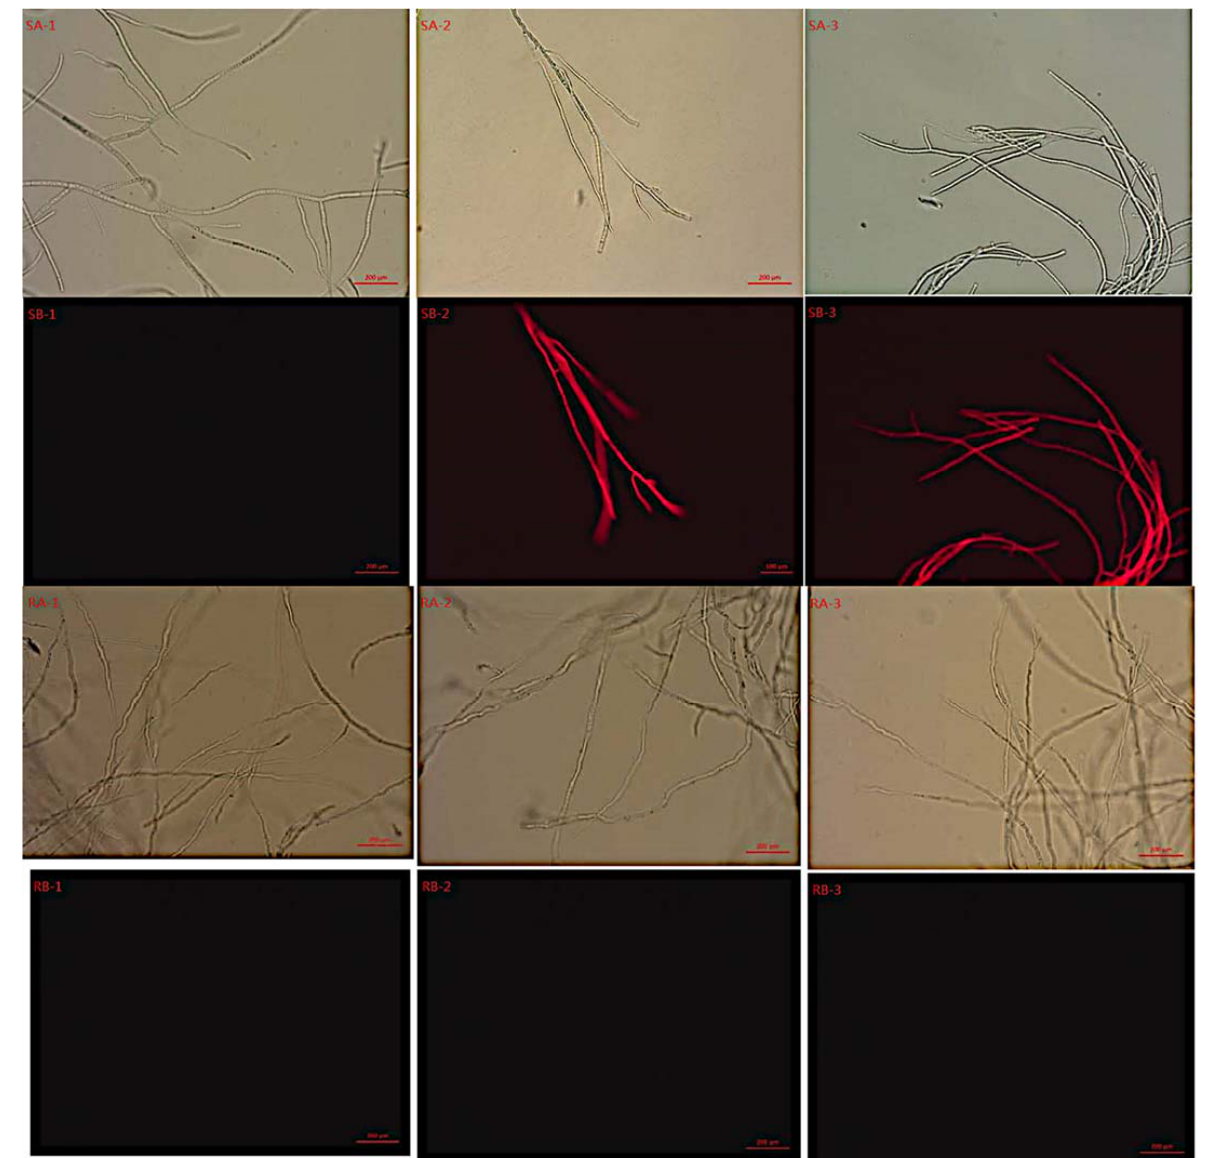
Figure 3. Effects of SYAUP-CN-26 on B. cinerea cell membrane with fluorescence microscope. S— sensitive strain ; R—resistant strain; 1—control; 2—26.758 µg/mL; 3—79.754 µg/mL; A—optical electron microscope; B—fluorescence microscope.